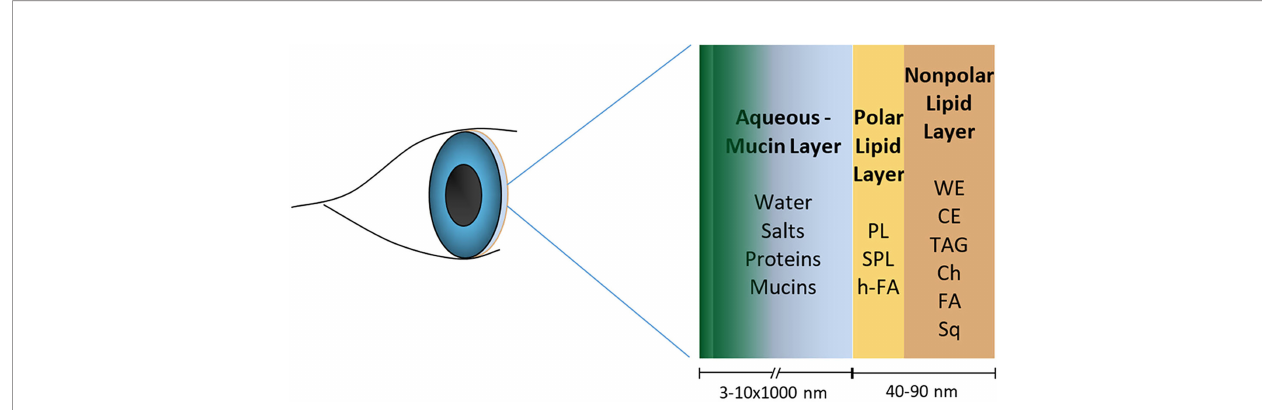
FIGURE 1 | Human tear fi lm model showing the lipid layer with nonpolar and polar lipids that have antimicrobial properties in playing a role in the ocular surface defense. The fi gure is not to the scale. (WE, wax esters; CE, cholesterol esters; TAG, triglycerides; Ch, free cholesterol; FA, free fatty acids; Sq, squalene; PL, phospholipids; SPL, sphingolipid; h-FA, hydroxy fatty